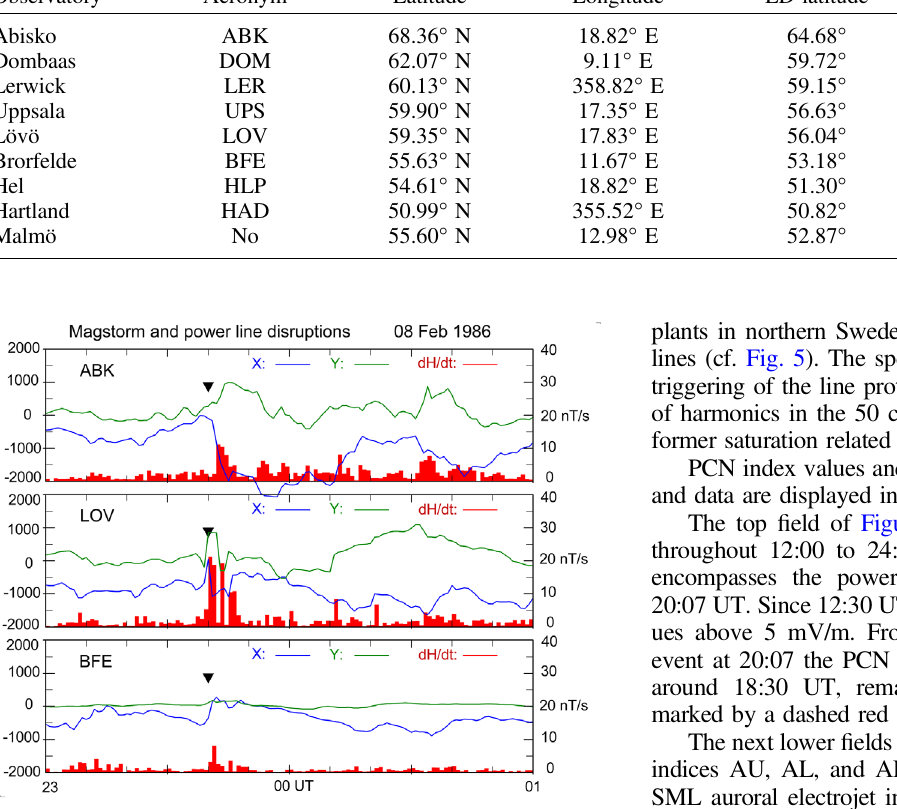
Fig. 1. Representative example of the horizontal components ( X , Y ) during a substorm with strong gradients displayed by red bars. Max. d H /d t = 21 nT/s. The onset time of GIC-related HV power line disruption is marked by the black